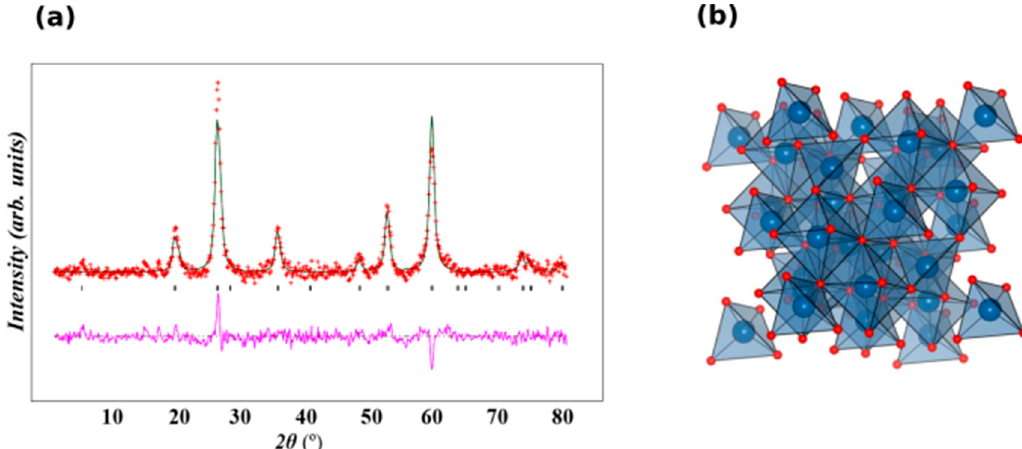
Figure 7. ( a ). XRD pattern with Rietveld refinement of Fe 3 O 4 . Crosses indicate the experimental data and the calculated profile is the black continuous line. The lowest curve shows the difference between experimental and calculated patterns. The black vertical bars indicate the expected reflection positions and ( b ) a polyhedral view of the Fe 3 O 4 structure. Blue and red are occupied by Fe and O respectively.